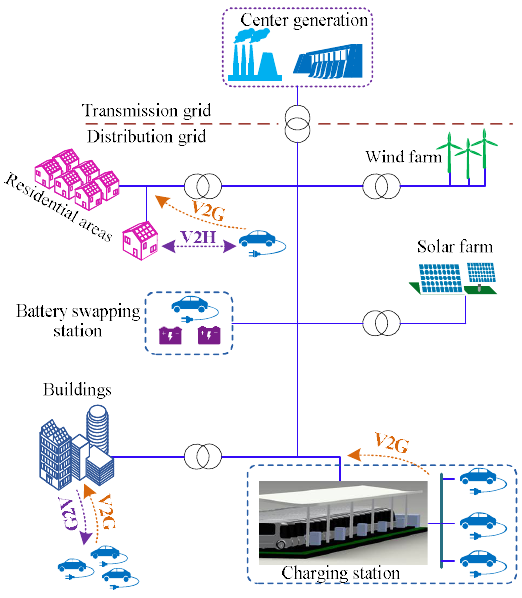
Figure 5. Paradigm of V2G.